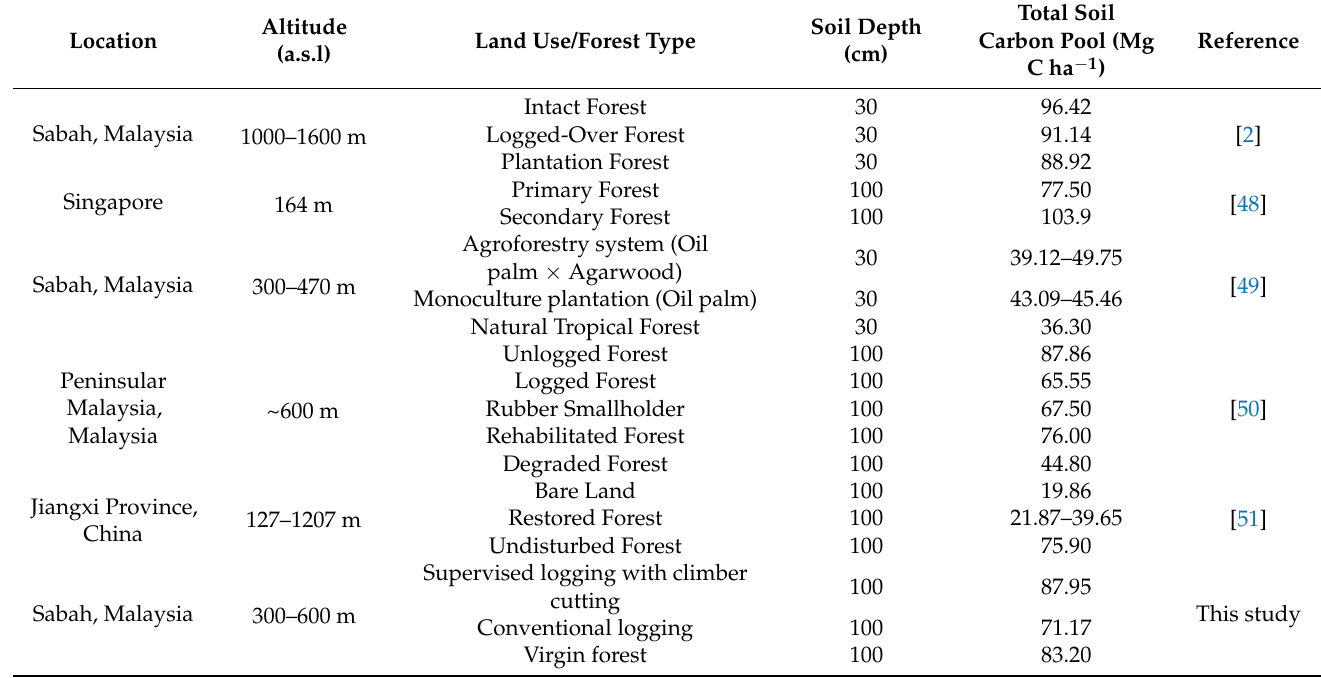
Table 6. The comparison of soil carbon pool across different